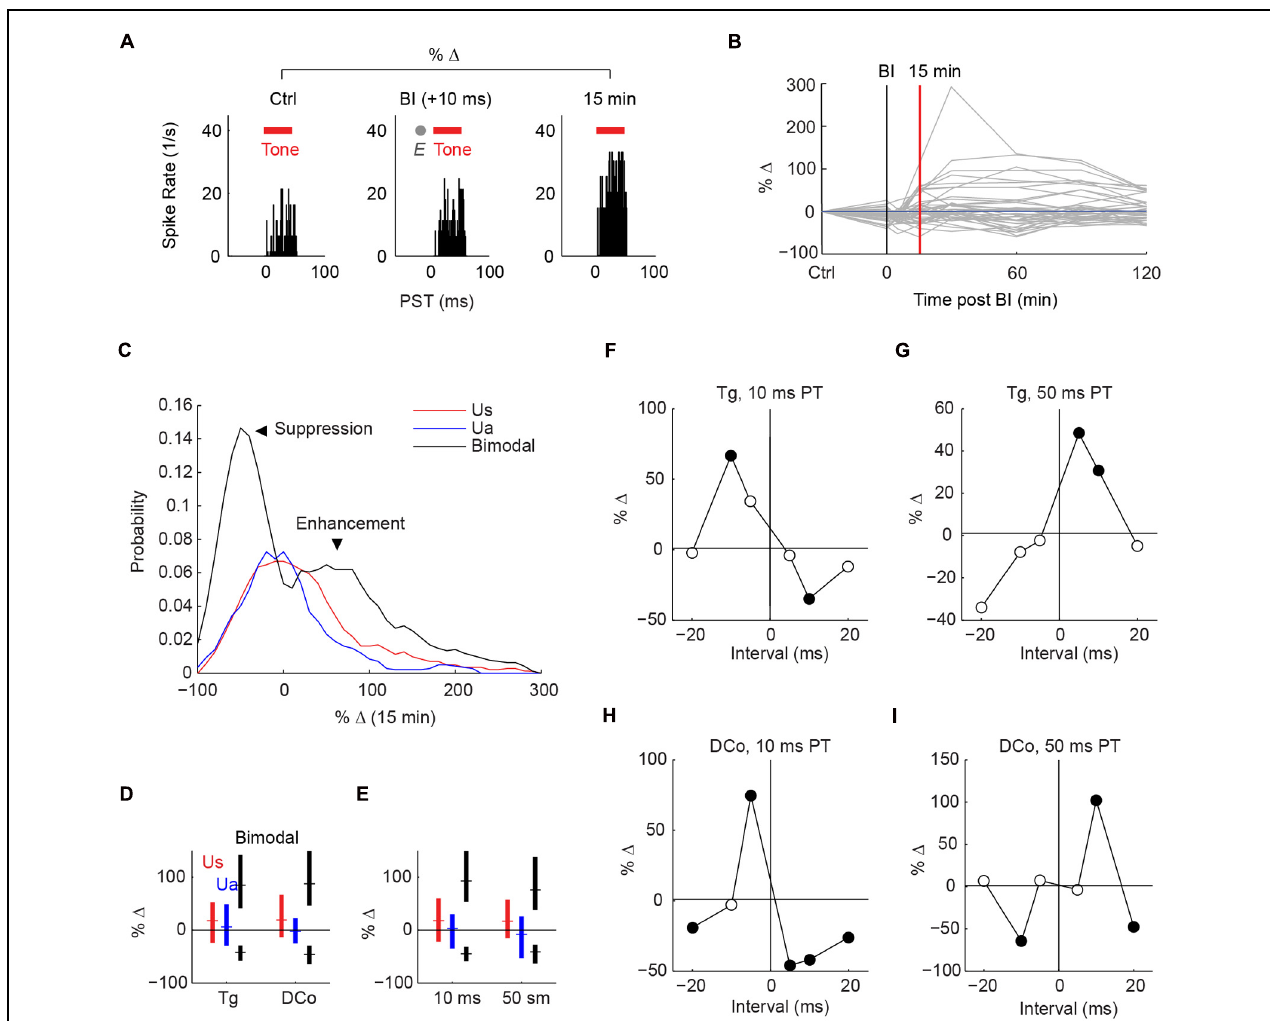
FIGURE 3 | Stimulus-timing-dependentplasticity induced by paired auditory and transcutaneous somatosensory stimulation. (A) An example of long-lasting enhancement (15 min) induced by paired face/Tg transcutaneous and 50 ms tone stimulation at a bimodal interval (BI) of + 10 ms. Plasticity is quantified as percent change in tone-evoked activity from pre- (control; Ctrl) to post-bimodal stimulation. Tone duration is denoted by red bars and electrical stimulation (E) by the gray dot. (B) Changes in tone-evoked activity from control to 0 (during pairing), 5, 15, 30, 60, 90, and 120 min after bimodal pairing. (C) Distribution (histogram) of percent change in tone-evoked responses from